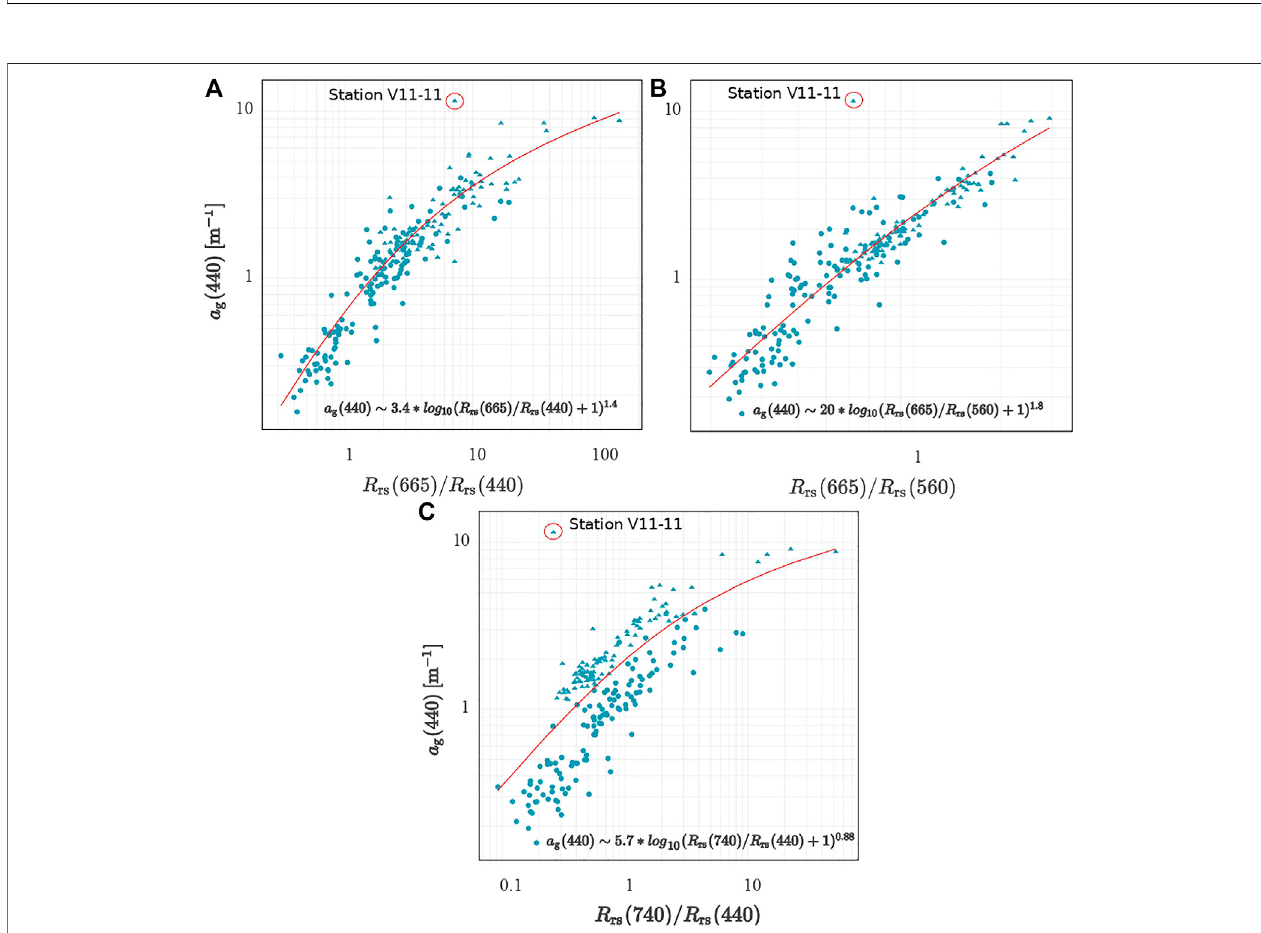
FIGURE5| Nonlinearempiricalalgorithmsfor a g (440)onlog-logspaceby (A) bandratio R rs (665)/ R rs (440), (B) bandratio R rs (665)/ R rs (560),and (C) bandratio R rs (740)/ R rs (440).Continuouslinecorresponds to fi tted values.Circles and triangles correspond tothedataacquiredintheEGSLand inJB respectively.Station V11-11 in JB is fl agged as optically shallow; the Secchi disk touches the bottom at 1.30 m.